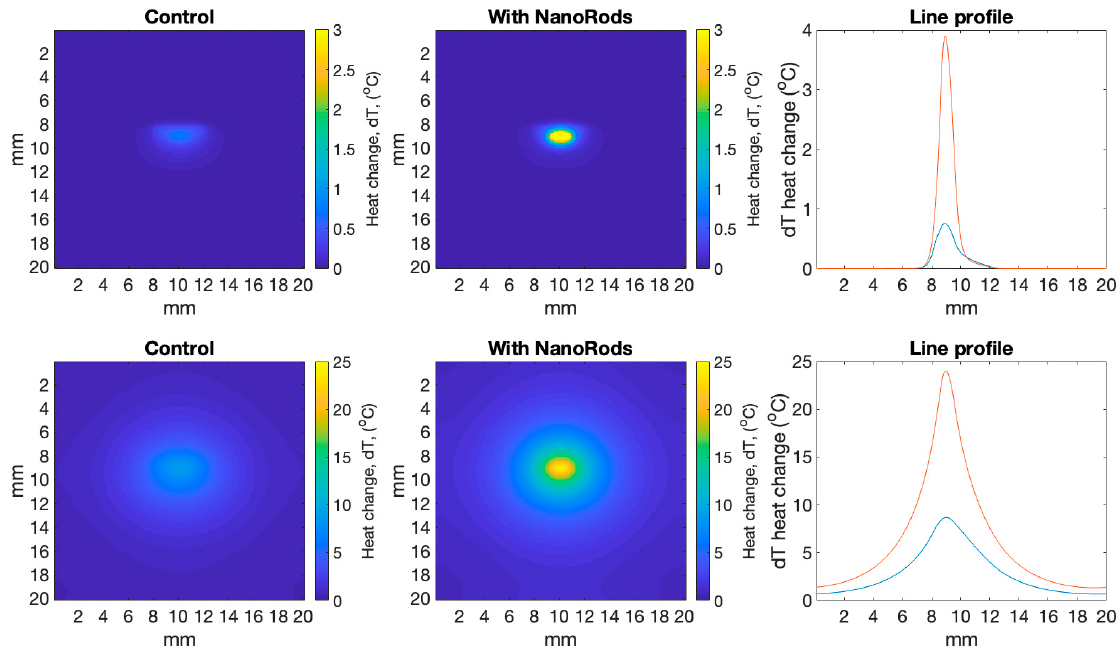
Figure 3. Shows heat rise ( ° C) per voxel in a 2D slice through the simulations from ARCTORUS comparing the control with tissue infused with gold nanorods, after one second (top panel) and 600 seconds (bottom panel). The line profile bisects the model from top to bottom at 10 mm.